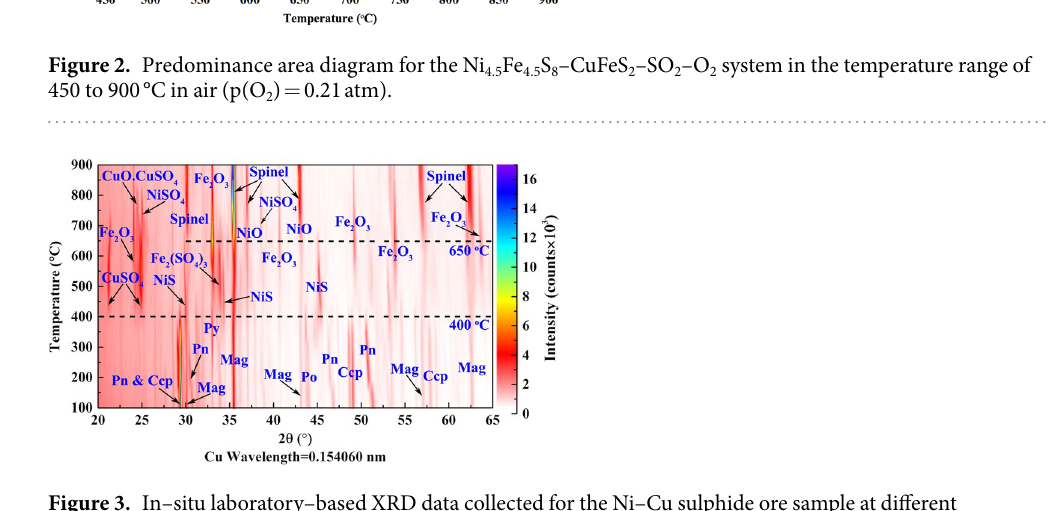
Figure 3. In–situ laboratory–based XRD data collected for the Ni–Cu sulphide ore sample at different temperatures (every 50 °C from 100 to 900 °C, with a heating rate of 5 °C/min) under the isothermal condition during the oxidative–roasting